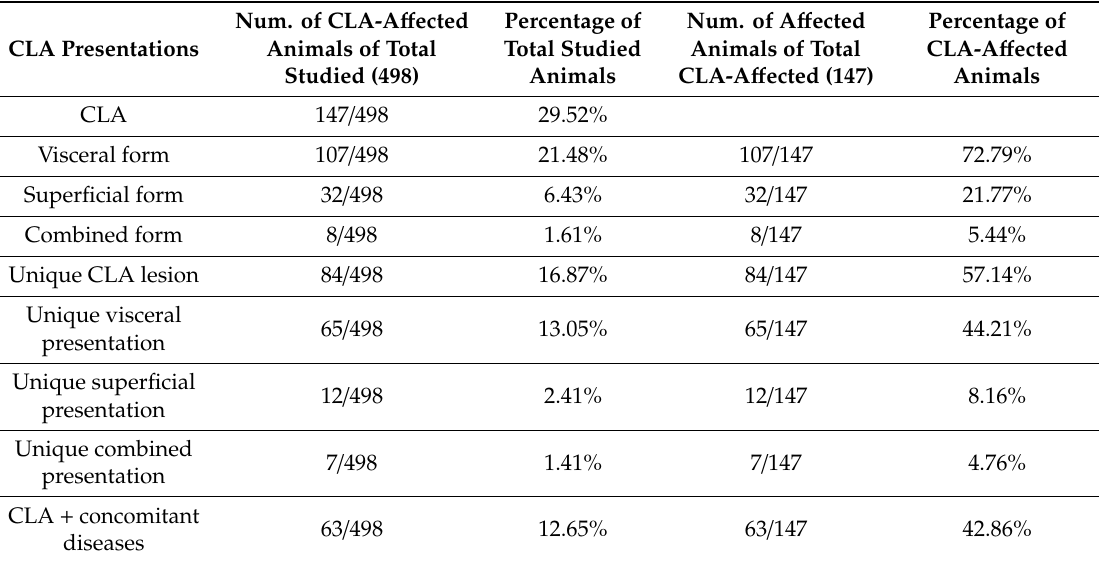
Table 1. Number and percentage of CLA-a ff ected animals regarding the total number of studied animals and the total CLA-a ff ected animals and the total CLA-affected animals.